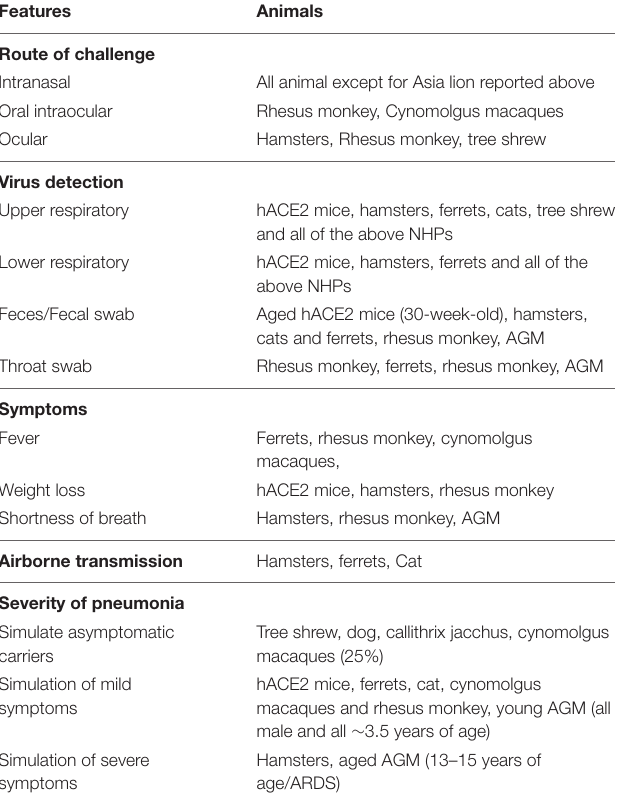
TABLE 1 | Comparison of features of experimental animals susceptible to SARS-CoV-2.